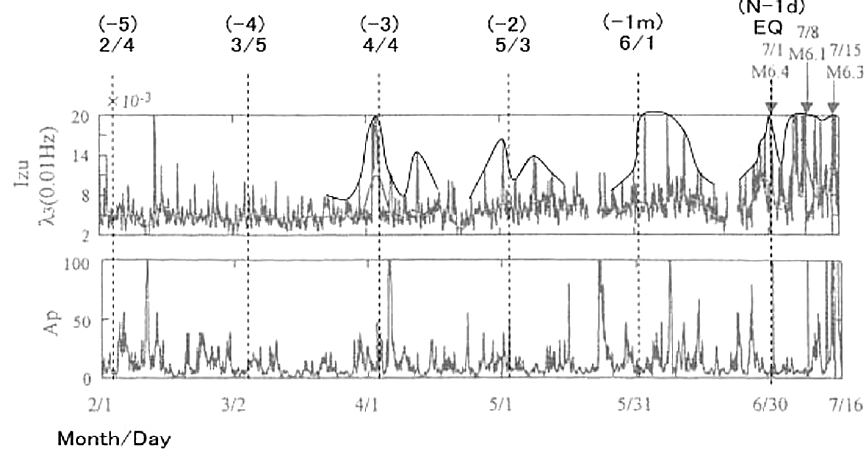
Fig. 2. An example of possible lithospheric modulation due to Earth’s tides (synodic period of 29.5days) appeared in the ULF emissions for the 2000 Izu EQ swarm. Adapted from Hayakawa et al.